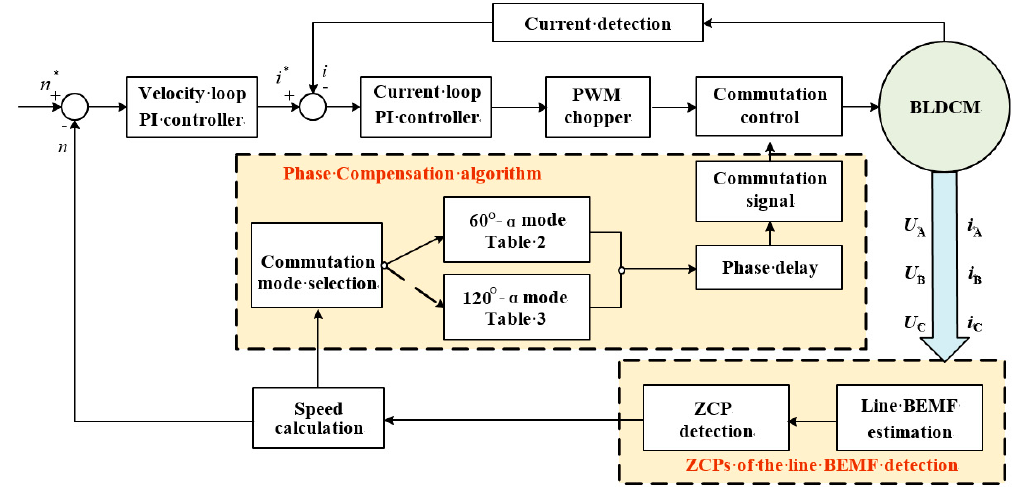
Figure 13. Block diagram of a BLDCM control